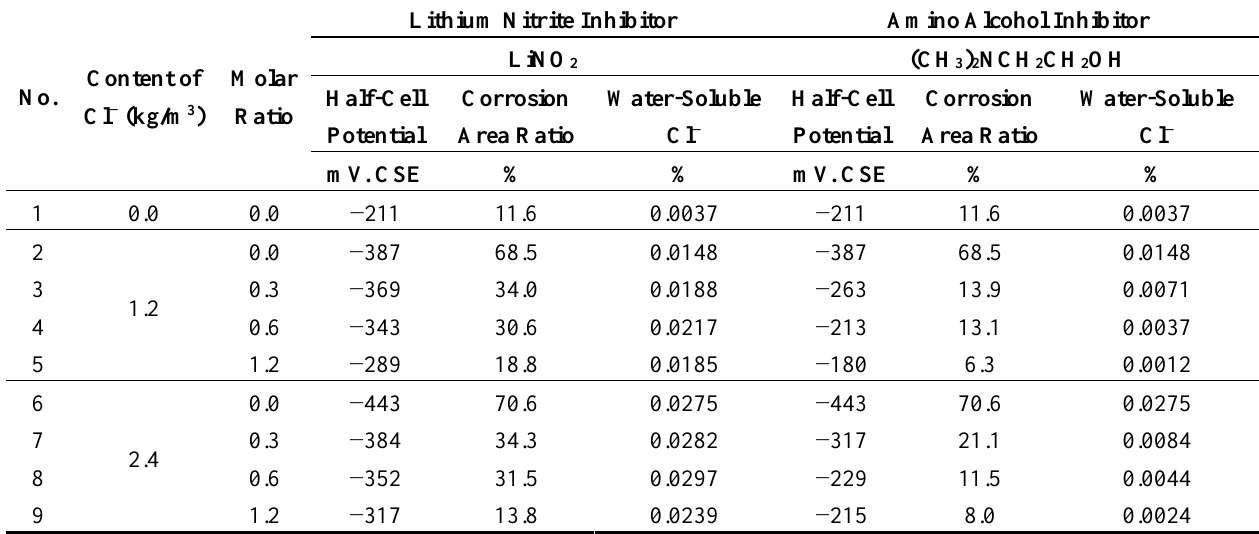
Table 8. Experimental test results of the reinforced concrete specimen. CSE: copper–copper sulfate